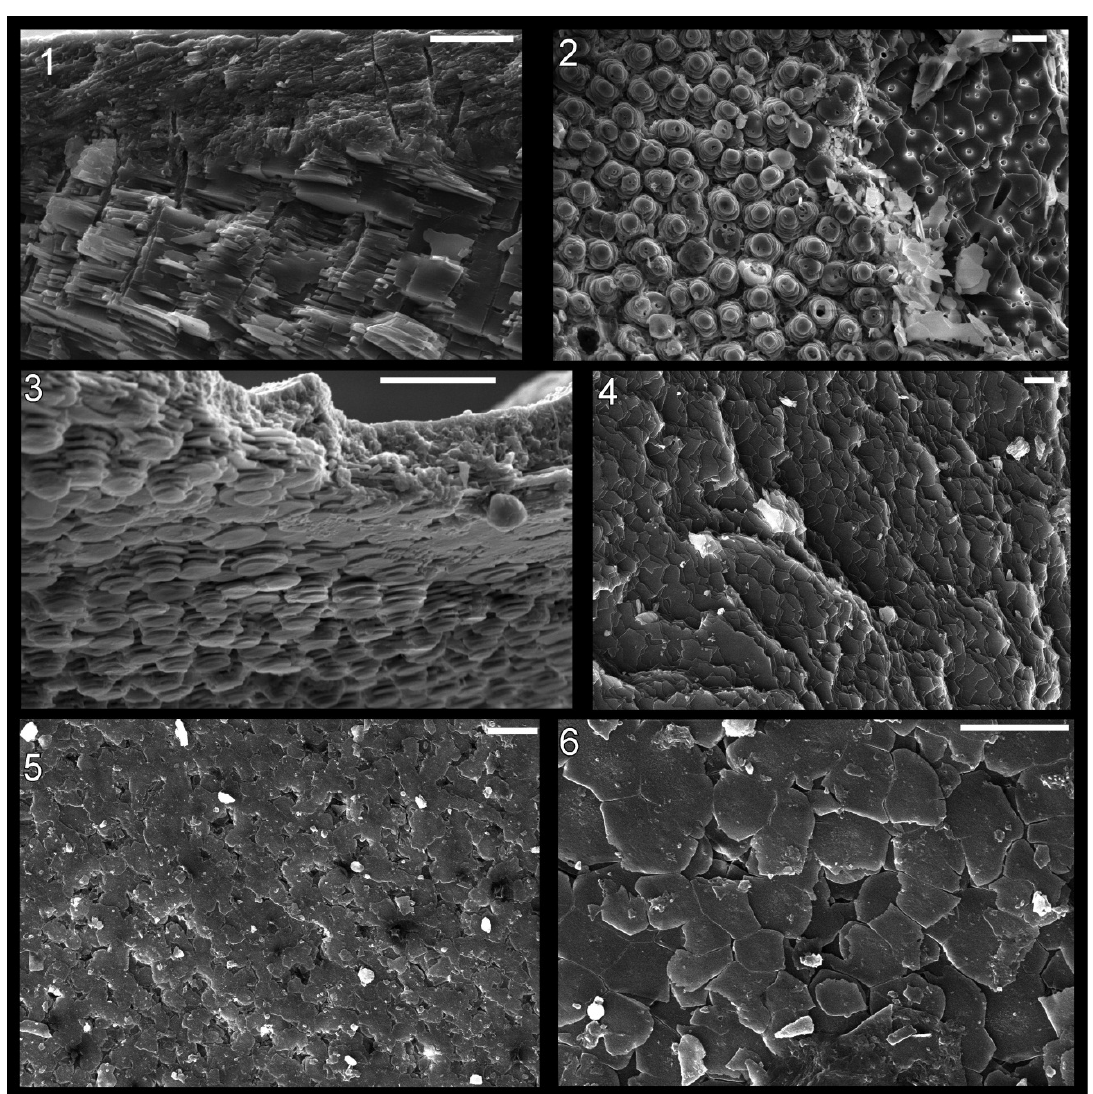
SBMNH 230515, ( 1 ) semi-transverse section near aperture showing innermost about 1/4 thickness of shell with top of photograph internal, ( 2 ) horizontal section of inner shell layer near internal shell surface, view is towards external surface; ( 3 ) the gastropod Seguenzia sp., MNHN 8528, semi-horizontal section of inner shell layer near internal surface, top of photograph is external; and ( 4 )–( 6 ) the cephalopod Nautilus pompilius , semi-horizontal and horizontal sections of the inner shell layer near internal shell surface at the aperture of the shell, view towards exterior. Scale bars all 10 µm. Image ( 3 ) was taken by Daniel